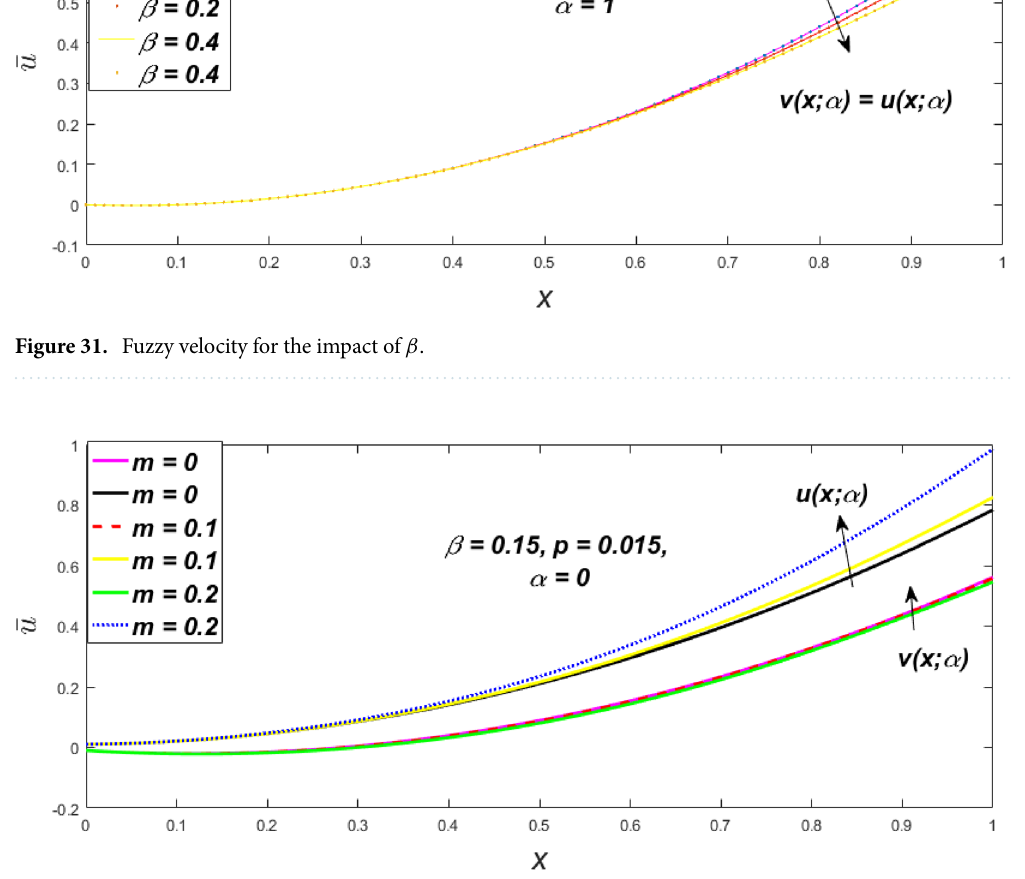
Figure 32. Fuzzy velocity for the impact of m.